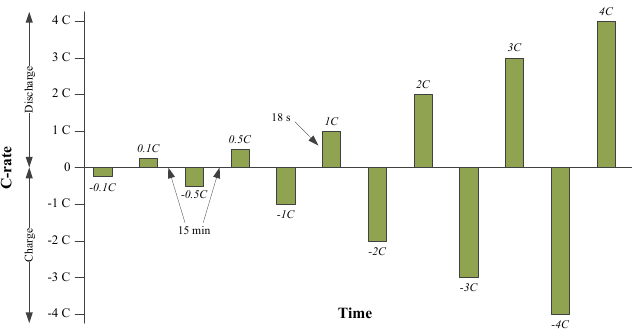
Figure 6. Pulse profile for measuring the internal resistance of the LFP/C battery.